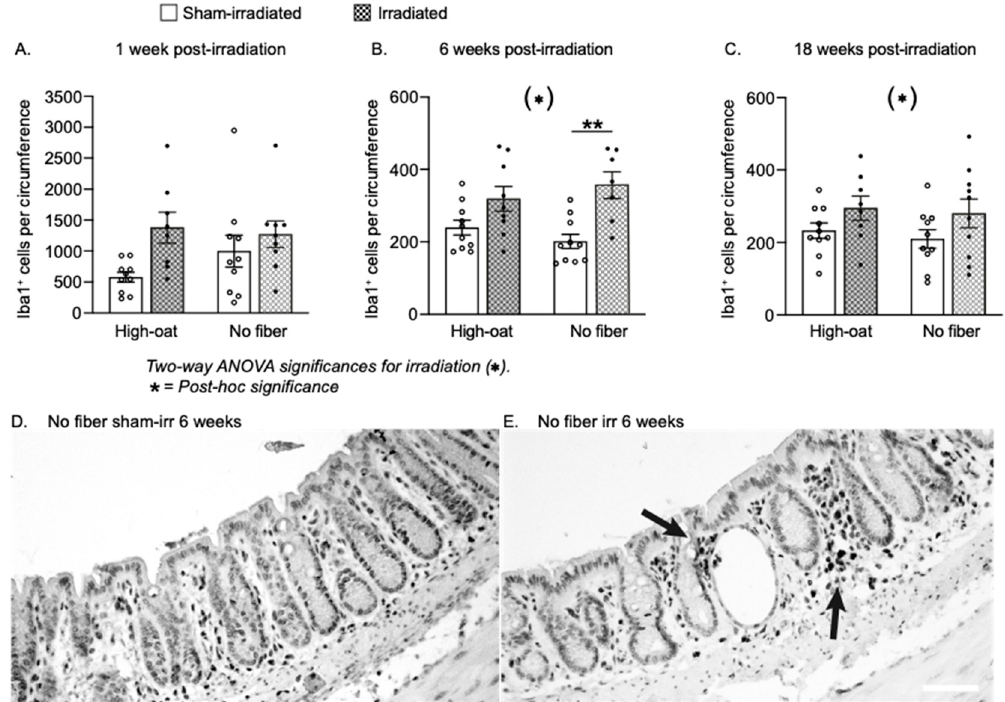
Figure 7. The average number of mucosal macrophages per circumference at 1 week, 6 weeks and 18 weeks after irradiation. ( A ). A potential increase in the number of macrophages was seen at one week in the High-oat irradiated mice compared to the High-oat sham-irradiated. ( B ). At 6 weeks, both diet groups had a greater abundancy of macrophages after irradiation than the sham-irradiated mice ( p = 0.0002 for irradiation). ** p = 0.0022. ( C ). At 18 weeks, there were still more macrophages in the mucosa of irradiated mice of both diet groups ( p = 0.0386 for irradiation). ( D , E ). Micrographs (20× magnification, scale bar 50 μ m) of macrophages visualized with immunohistochemistry using an antibody against Iba1 and a DAB stain. Iba1 + macrophages were found in the mucosa of both sham-irradiated ( D ) and irradiated ( E ) animals but were more abundant in the irradiated animals and often clustered (arrows). Data are shown as mean ± S.E.M.